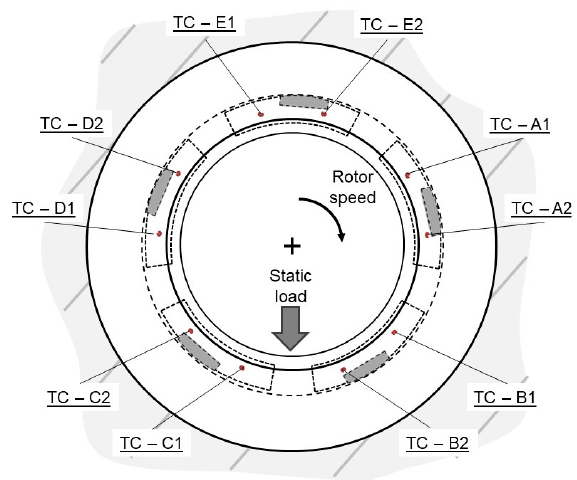
Figure 7. Direct Lube Rocker Pivot bearing with thermocouples